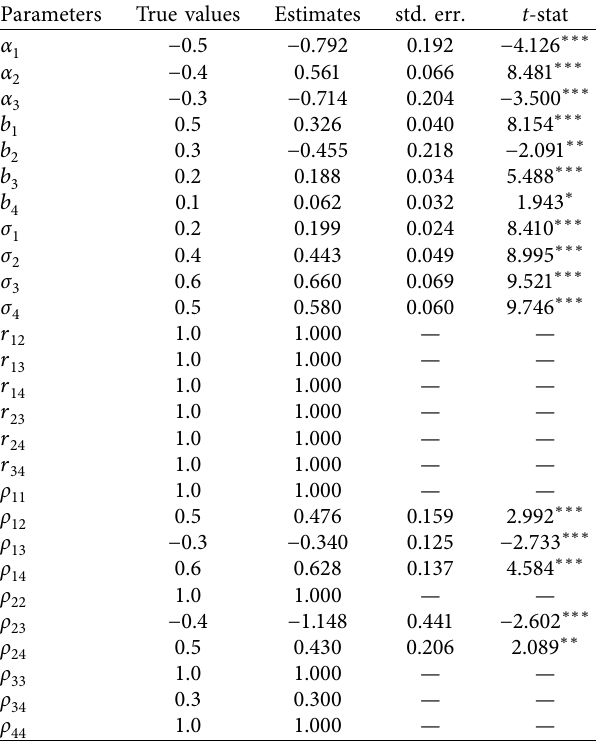
Table 3: Simulation results for a four-alternative MMNP model of 5,000 observations when random coefficients are associated with generic